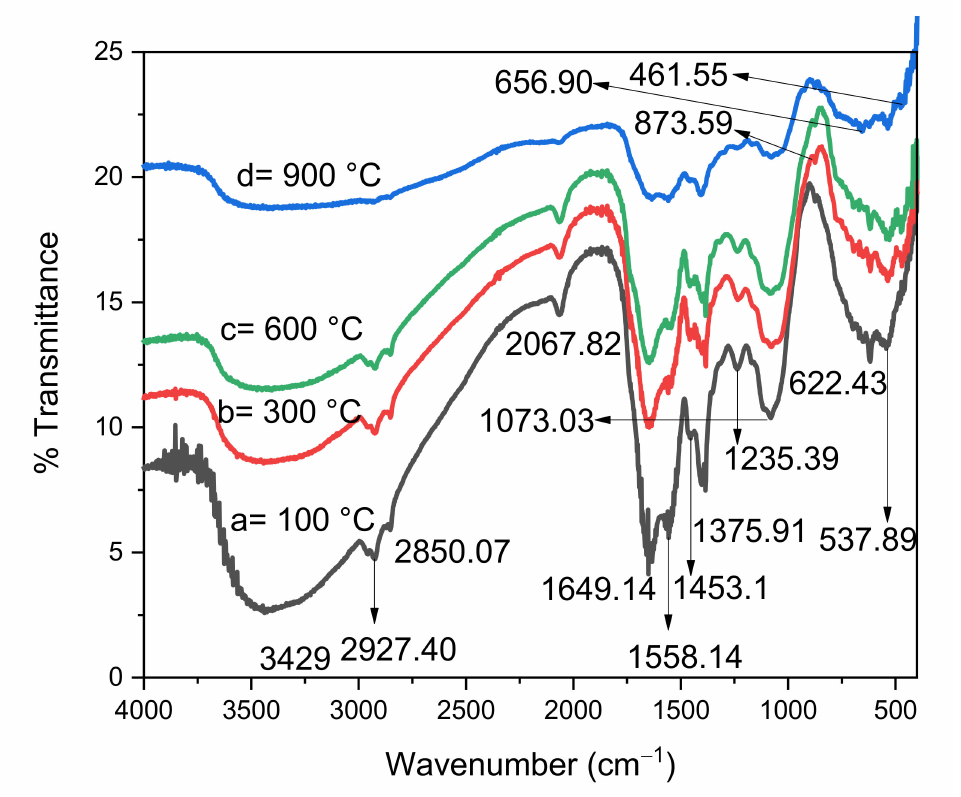
Figure 3. FTIR spectra of ZnO-ZrO 2 NC calcined at different